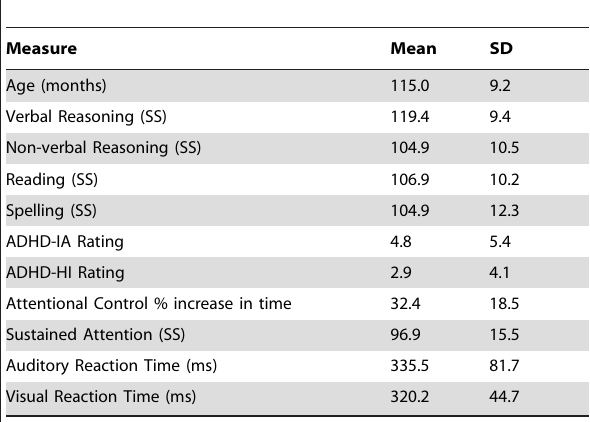
Table 1. Descriptive statistics for the group of 21